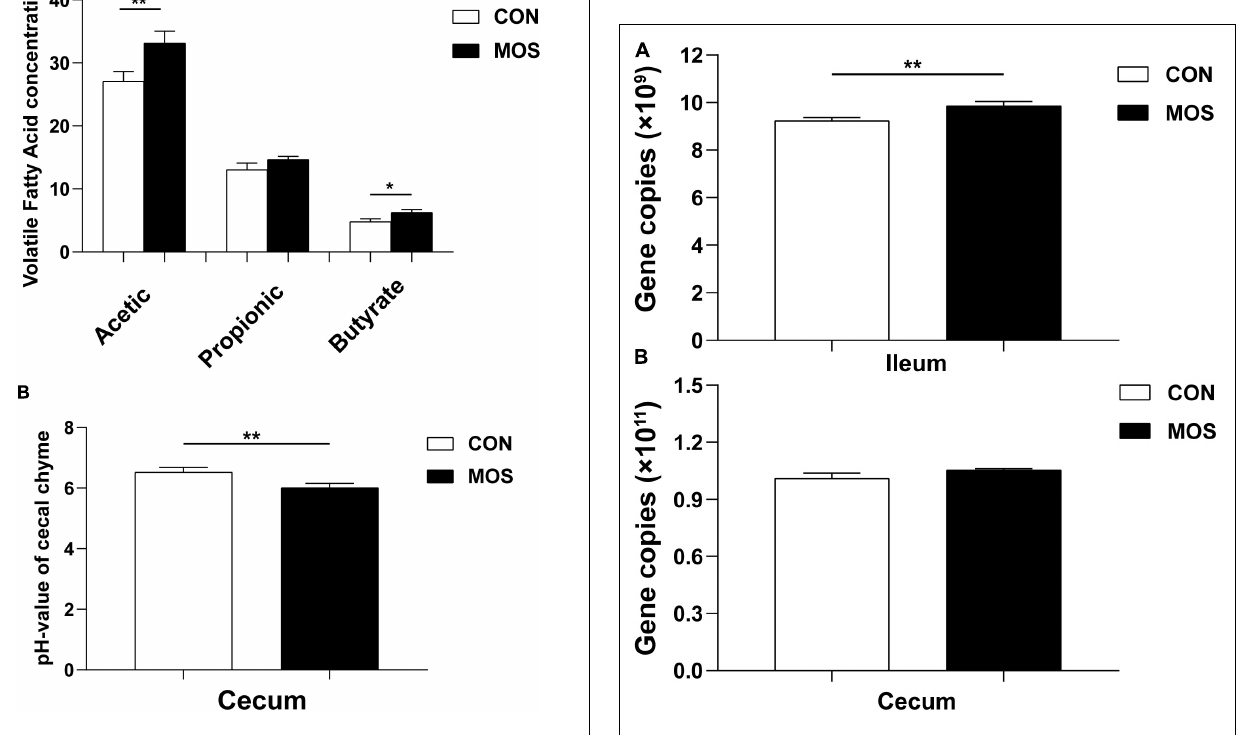
Frontiers in Microbiology |